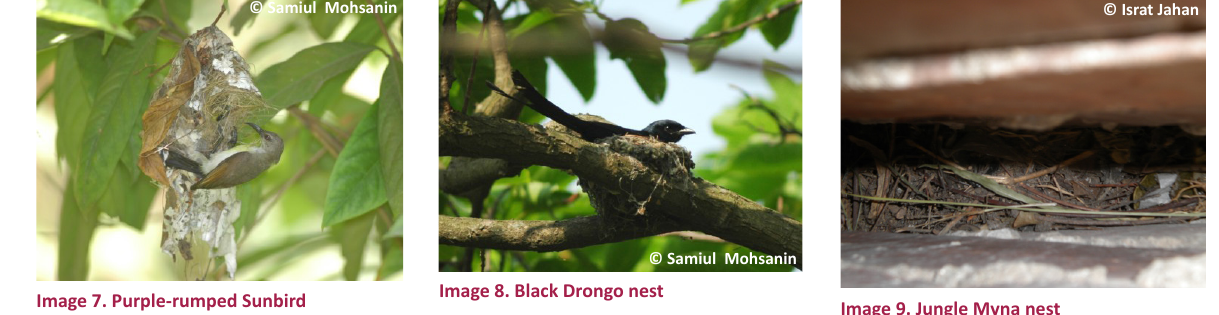
FlamebackImage 7. Purple-rumped Sunbird